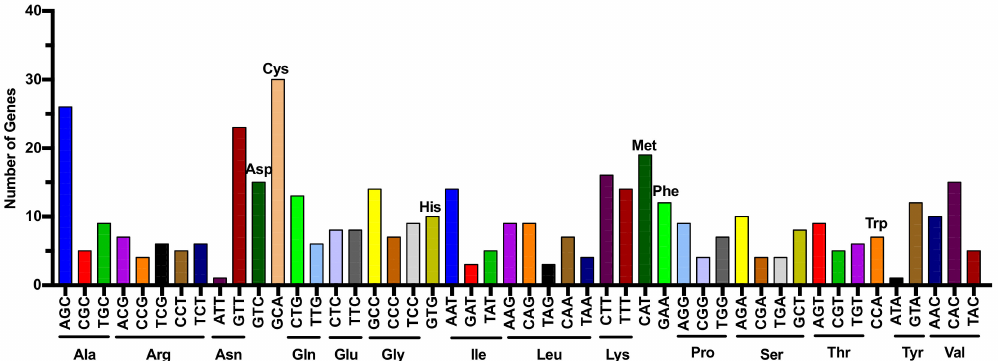
Figure 1. Multiple transfer RNA (tRNA) genes in human genome. Numbers of tRNA genes are presented for different amino acids and anticodons. Each graph with different colors indicates a different amino acid. Various isoacceptors (tRNA acceptors that accept the same amino acids) exist for each amino acid. Existence of isodeciders (tRNA genes with the same anticodon but different sequences elsewhere in the tRNA body) for each isoacceptor expands the source of RNAs for generation of diverse tRNA-derived small RNAs